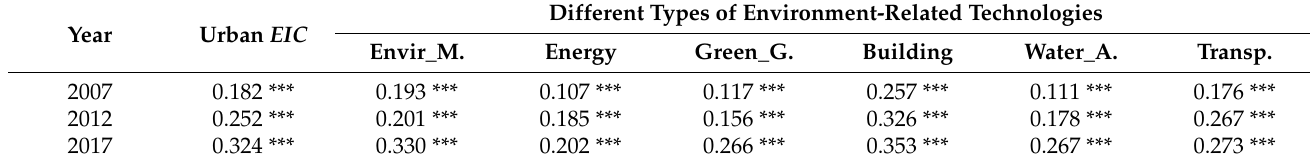
Table 4. Global Moran’s I index of urban EIC (2007, 2012, and